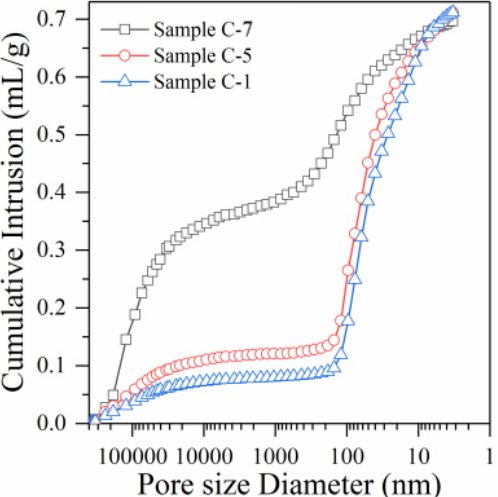
Figure 3. Mercury injection curve of samples C-1, C-5, and C-7.